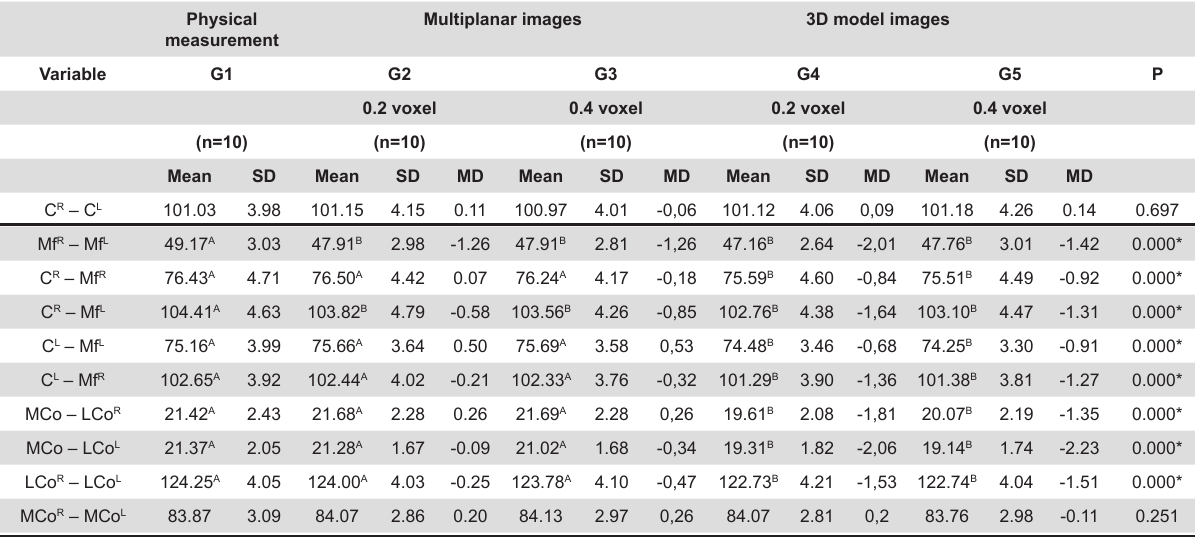
Table 2- Mean (mm) and Standard Deviation (SD) of linear measurements for dry mandibles compared to cone-beam computed tomography (CBCT) images with different voxel sizes [analysis of variance (ANOVA) for repeated measures and Dunnett’s Physical Multiplanar images 3D model images measurement Variable G1